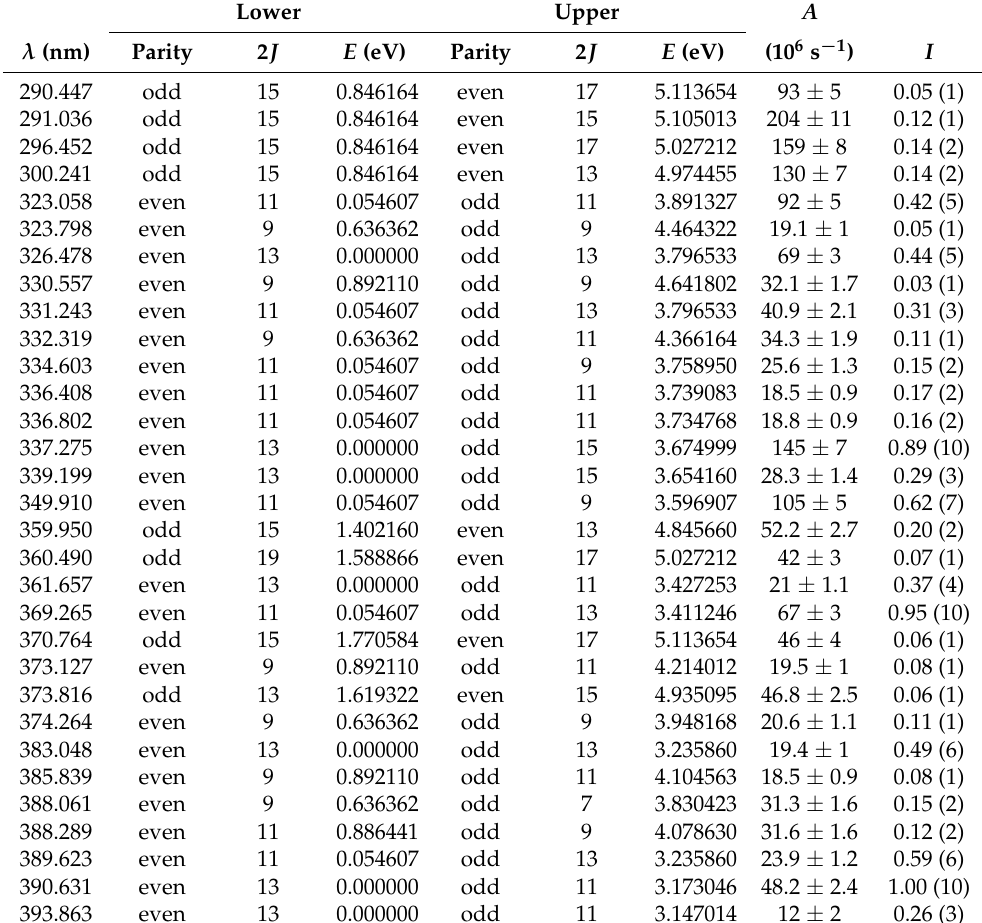
Table 1. Transitions used in the present analysis. Wavelength ( λ ), parity, 2 J value, level energy ( E ), and transition probability ( A ) are taken from Lawler2008 [10] except for the 393.863 nm line. For the 393.863 nm line, wavelength, parity, 2 J value, and level energy taken from the NIST database [5] and the transition probability obtained in the present measurement are listed. The sensitivity-corrected relative intensities I in the present LIBS spectrum, normalized to the 390.631 nm line, are listed for all the